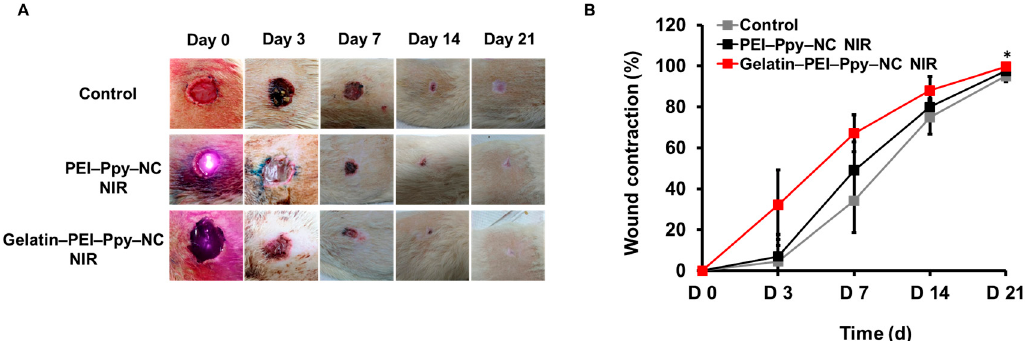
Figure 8. ( A ) Periodical wound healing evaluation (full thickness wound in the Wistar rat model): macroscopic images of the wound site and wound area of the control and two experimental groups at different time points (day (d) 0, 3, 7, 14, and 21) ( n = 3); ( B ) Wound contraction (%) at various stages of wound healing and complete wound closure from day 0 to day 21( n = 3) ( p < 0.05).